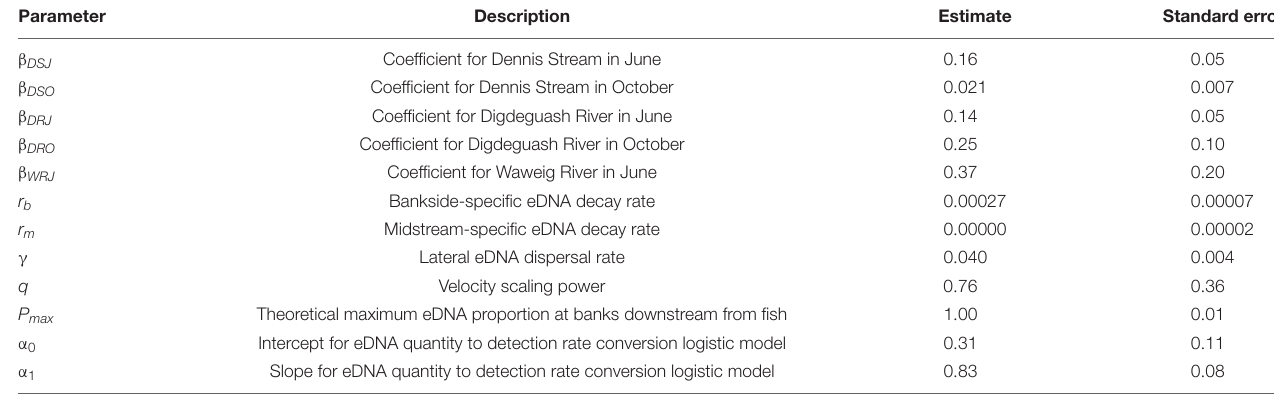
TABLE 2 | Parameter estimates and standard errors for eDNA detection rate and concentration models. Parameter